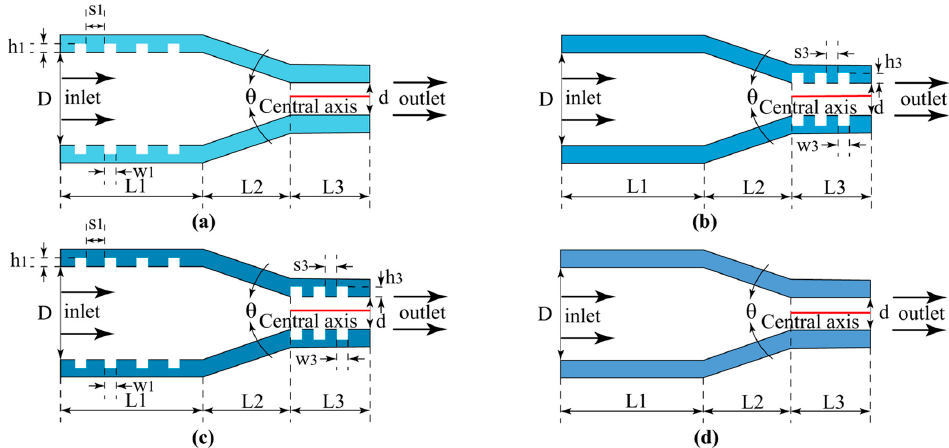
Figure 10. Conceptual model: ( a – c ) BSCN and ( d ) conventional straight cone nozzle. The average velocity along the central L3 axis of each BSCN was subtracted from the average velocity on the L3 central axis of the conventional straight cone nozzle. The ob ‐ tained results were divided by the average velocity along the central axis of L3 in the out ‐ let of the conventional straight cone nozzle, and finally, the velocity increase rate of the BSCN was obtained. Then, the curves of the velocity rise rate of each BSCN were drawn, as shown in Figure 11.